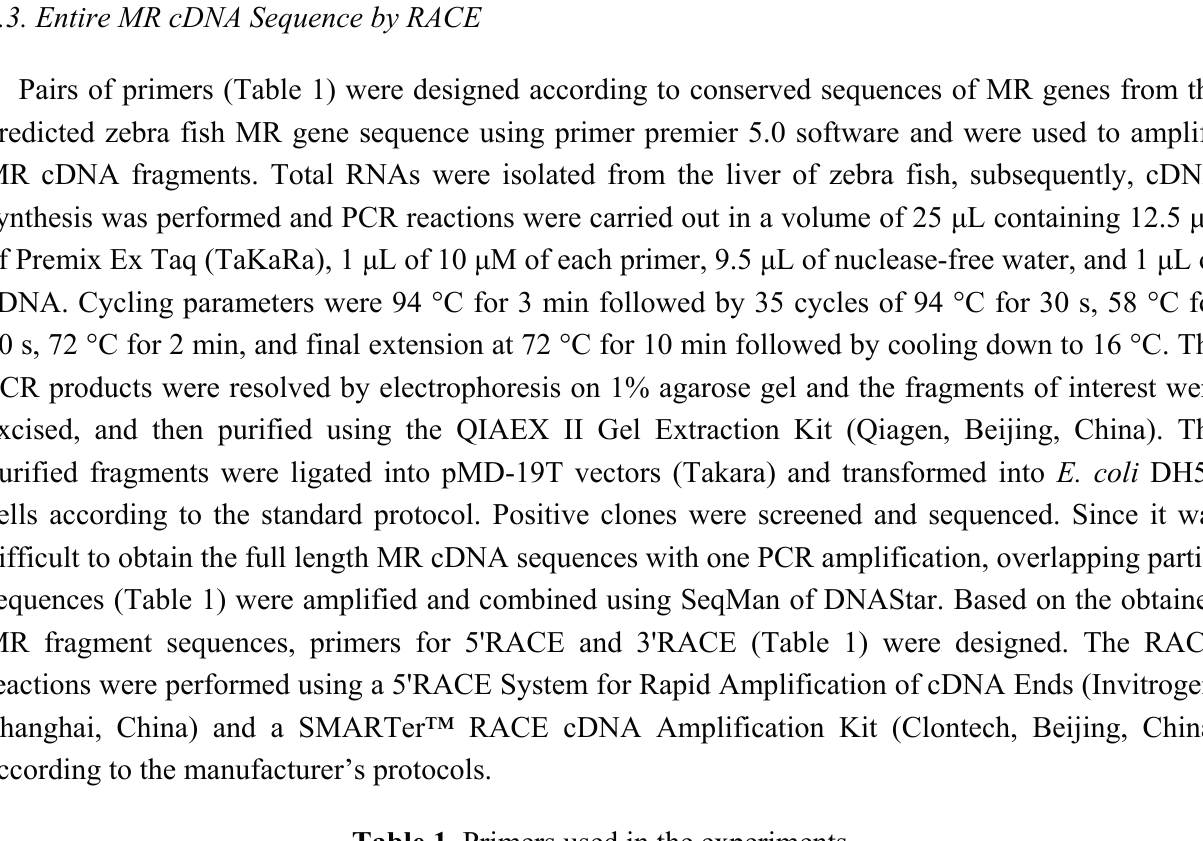
Table 1. Primers used in the